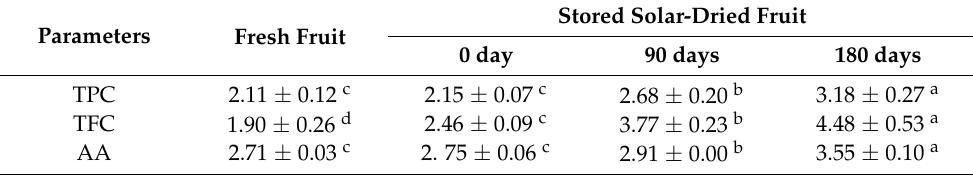
Table 5. Total phenolic content (TPC; mg GAE/g DM) and total flavonoid content (TFC; mg Que/g DM) content and antioxidant activity (AA; 2,2-diphenyl-1-picrylhydrazyl (DPPH) mg trolox/g DM) of fresh and solar-dried tomato